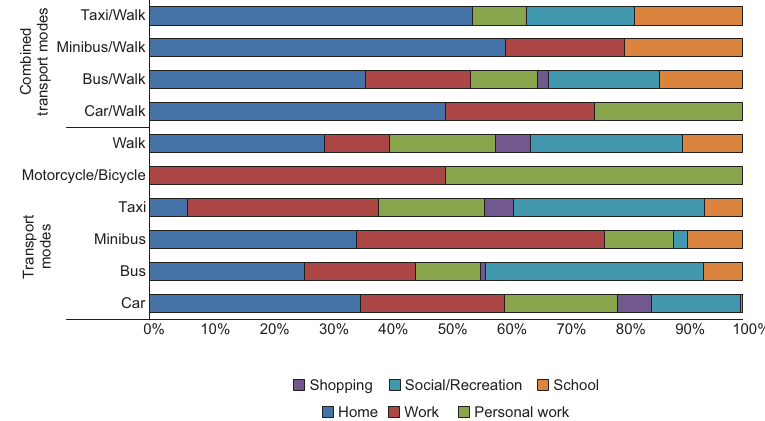
Fig. 6. Types of transportation used based on travel purpose in the city of